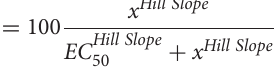
multiplied by 100 (Equation 2).